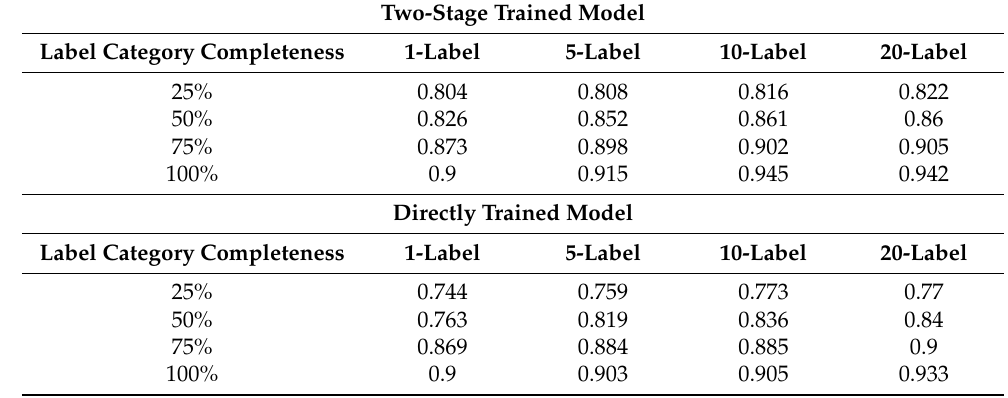
Table 5. Purity results.